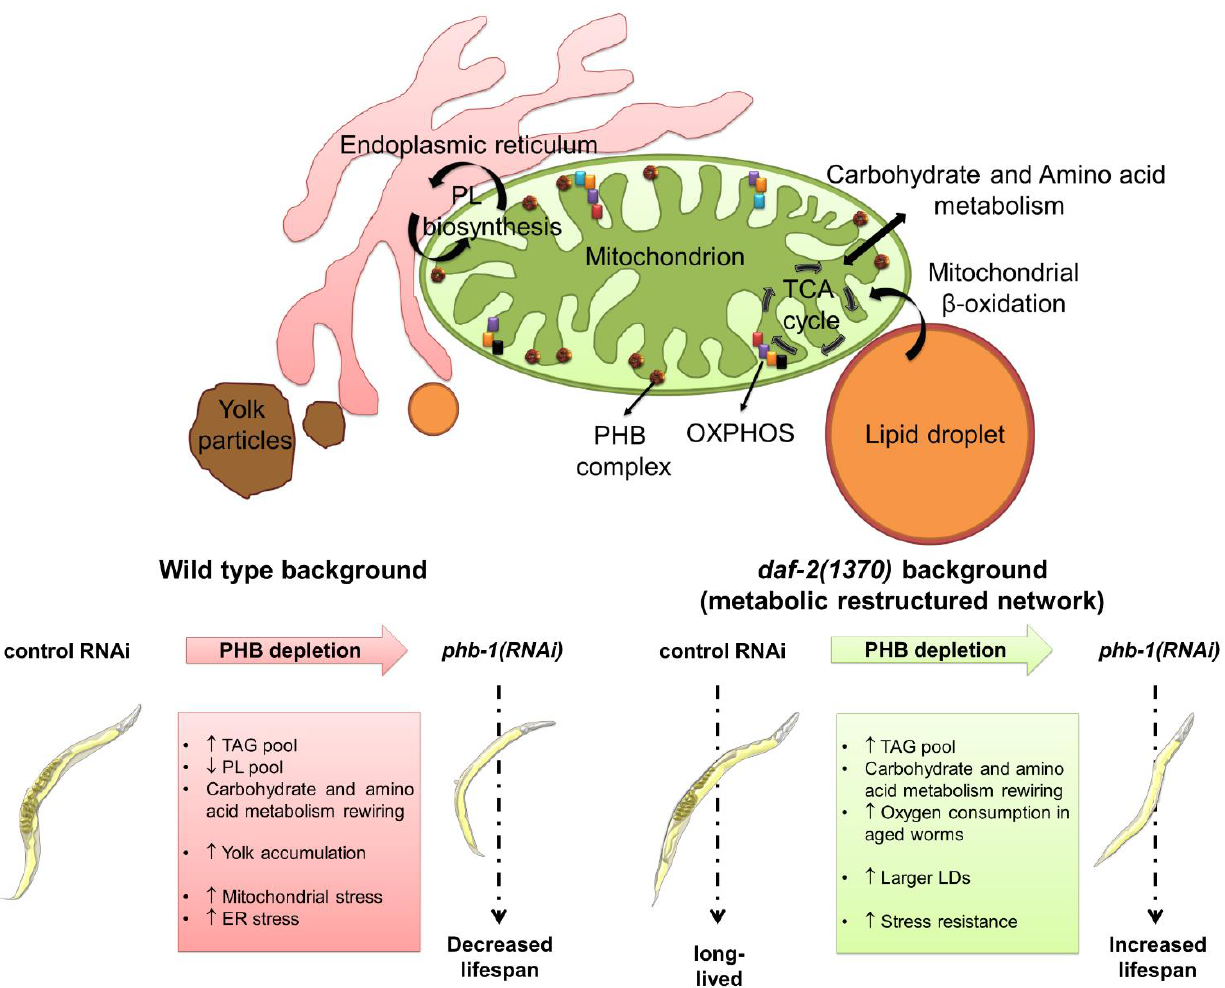
Figure 1. Metabolic rewiring in PHB-mediated ageing regulation. The PHB complex modulates mitochondrial membrane lipid composition, presumably by altering the balance of PL, leading to deregulation of mitochondrial function, including oxidative phosphorylation (OXPHOS). Mitochondrial dysfunction affects amino acid and carbohydrate metabolism in an IIS dependent-manner. Concomitantly, mitochondrial dysfunction reverberates, in an IIS-dependent manner, in other organelles such as yolk, lipid droplets, and the endoplasmic reticulum, leading to opposing ageing